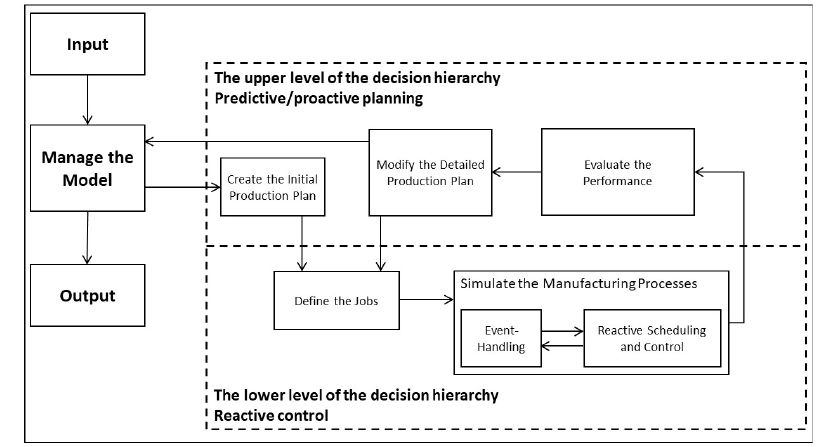
Fig. 1. Simplified flow chart of the solving